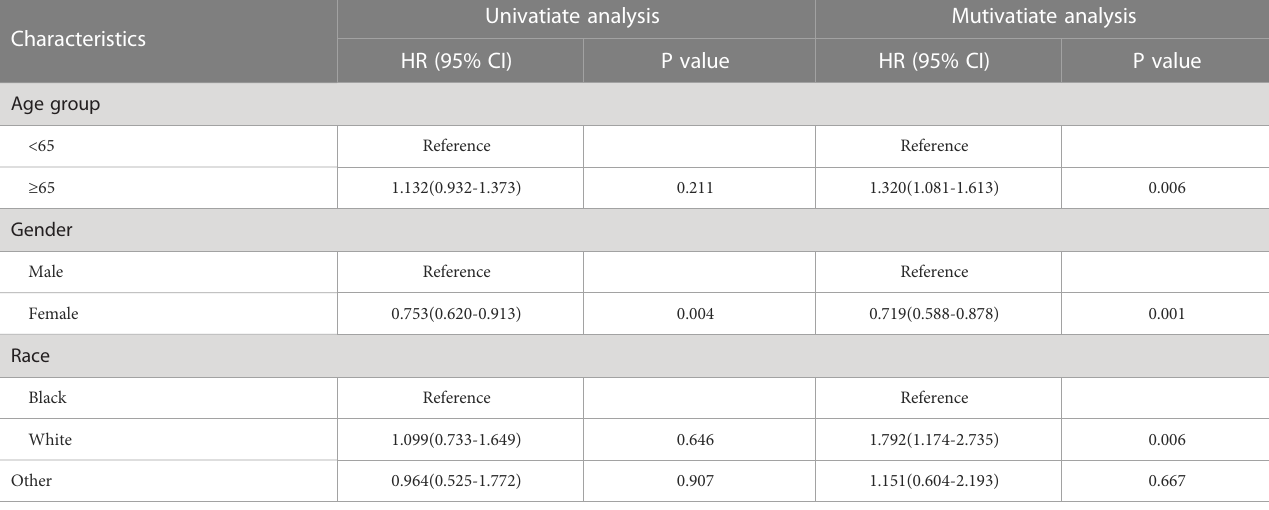
TABLE 4 Univariate and multivariable Cox regression for cancer-speci fi c survival among SCLC patients with BM.